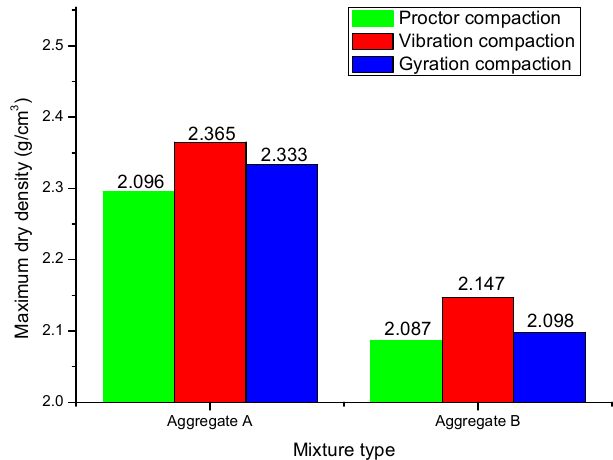
Figure 9. Optimal moisture contents of Aggregate A and Aggregate B. Figure 10. Maximum dry densities of Aggregate A and Aggregate B. Appl. Sci. 2018 , 8 , x FOR PEER REVIEW